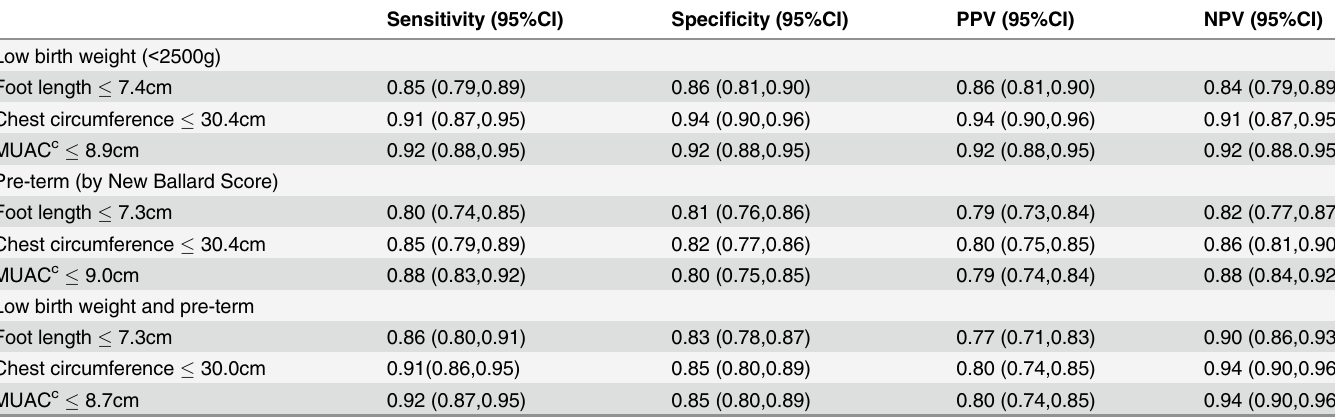
Table 2. Sensitivity, specificity, and positive and negative predictive values of optimal cut-points 1 for each outcome and anthropometric measure.